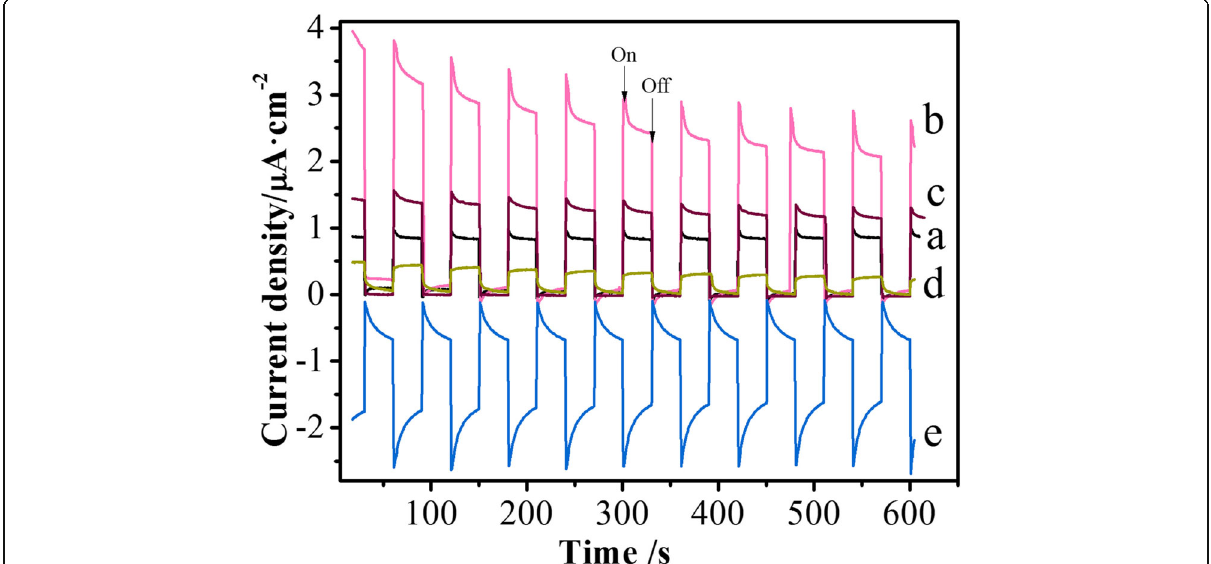
Fig. 6 Photocurrent curves versus time: a ZnO, b ZB_0.01, c ZB_0.05, d ZB_0.2, and e BiVO 4 . The irradiating light was produced by the xenon lamp with a UVIRCUT 420